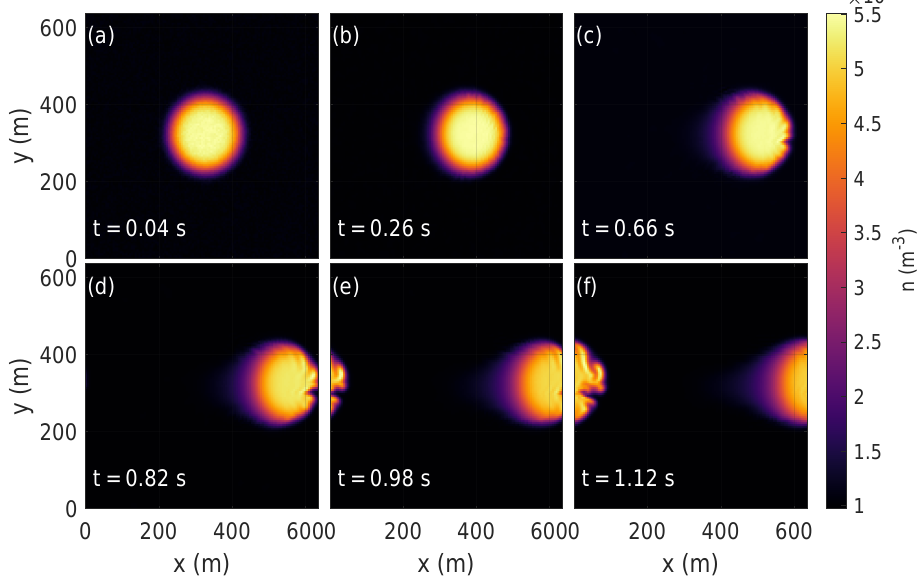
Figure 5. Density color plots of 2D slices at the mid-plane of ˆ z showing the evolution of a 3D plasma enhancement cloud simulation in a highly collisional regime. Panels ( c , d ), show the xy leading edge becomes unstable and starts to bifurcate. Panels ( e , f ), show the continual growth of the bifurcation as finger-like structures curl up along the ˆ y direction. Note that the cloud elongates in the ˆ x direction as the tail grows, as seen in Figure